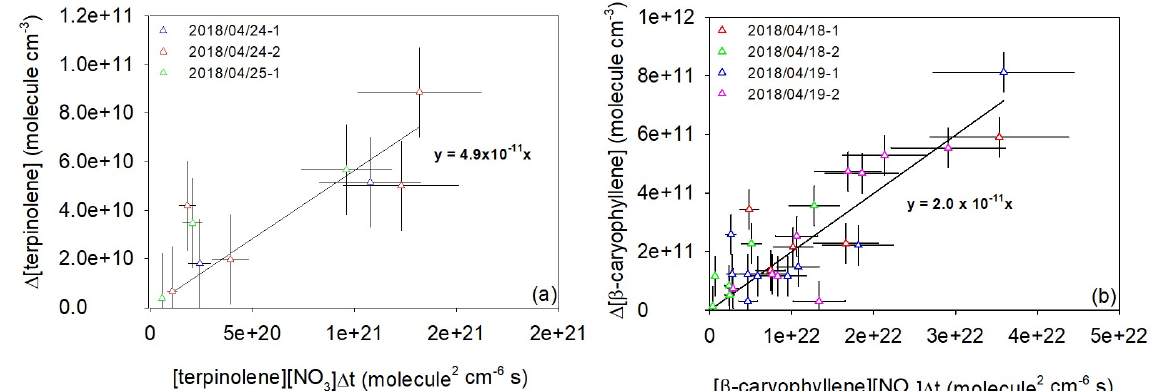
Figure 3. Absolute kinetic plots for terpinolene (a) and β -caryophyllene (b)